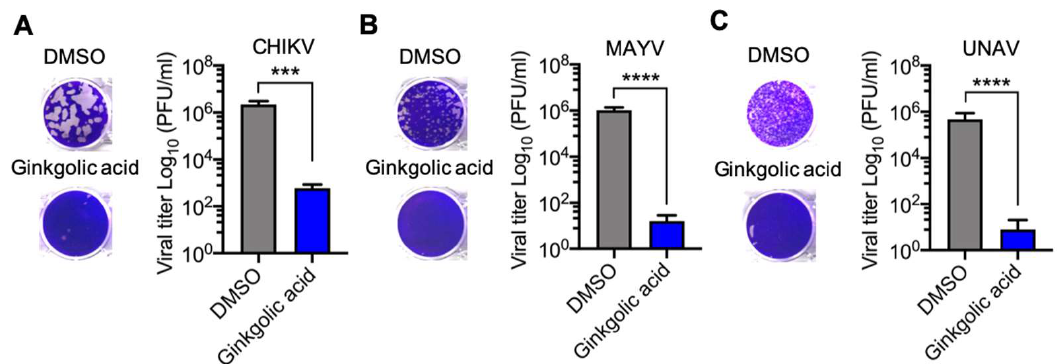
Figure 3. Ginkgolic acid alters Alphavirus particles’ infectivity. Approximately, 10 6 PFU of CHIKV ( A ), MAYV ( B ) or UNAV ( C ) were incubated in serum-free medium with Ginkgolic acid at 10 µ M or 0.1% DMSO as a control for 1 h at 37 ºC. Then, the alphaviruses were directly titrated in Vero or Vero-E6 cells and the remaining virus was quantified using a plaque-forming assay. Viral titers were represented as plaque-forming units per milliliter (PFU / mL). Data were analyzed using the Mann & Whitney test. Statistically significant di ff erences are shown: *** p < 0.001; **** p <